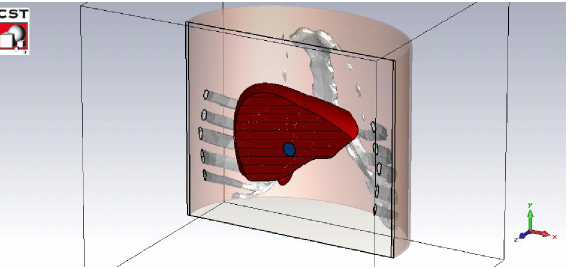
images of the abdomen area in a real patient. It consists of four different tissues: fat, liver, bone and cancer. Each of